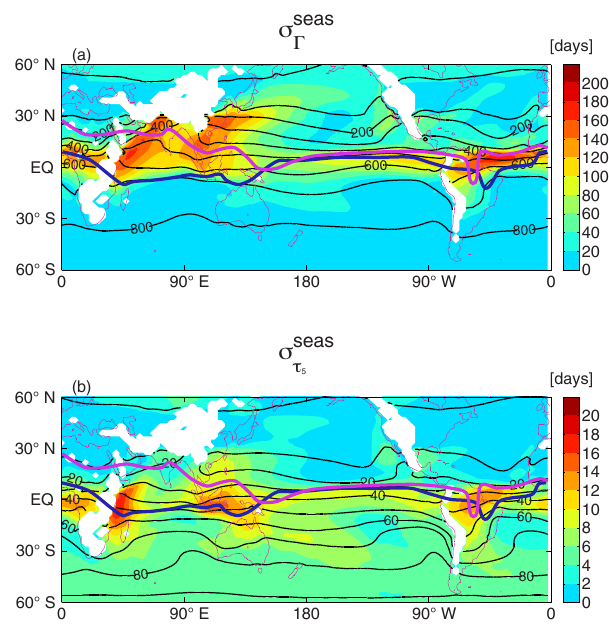
Figure 4. Maps of seasonal variability of (a) (cid:48) and (b) τ 5 at 900hPa. Thin contours show climatological mean tracer ages (in days), and blue and pink curves show approximate location of the ITCZ in DJF and JJA, respectively.